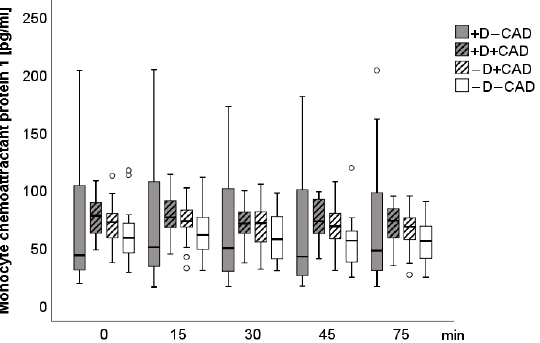
Figure 4. Boxplot of Interleukin 6 for each measurement time. Circle: ordinary outliner defined as one and a half boxlength, asterisk: extreme outliner defined as above one and a half to threefold boxlength.